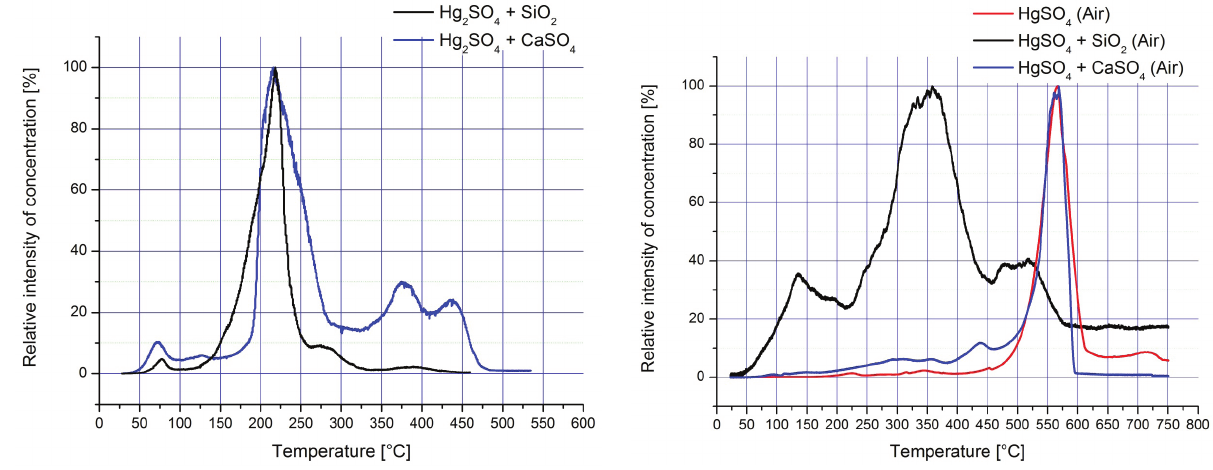
SO , purged with air. 2 4